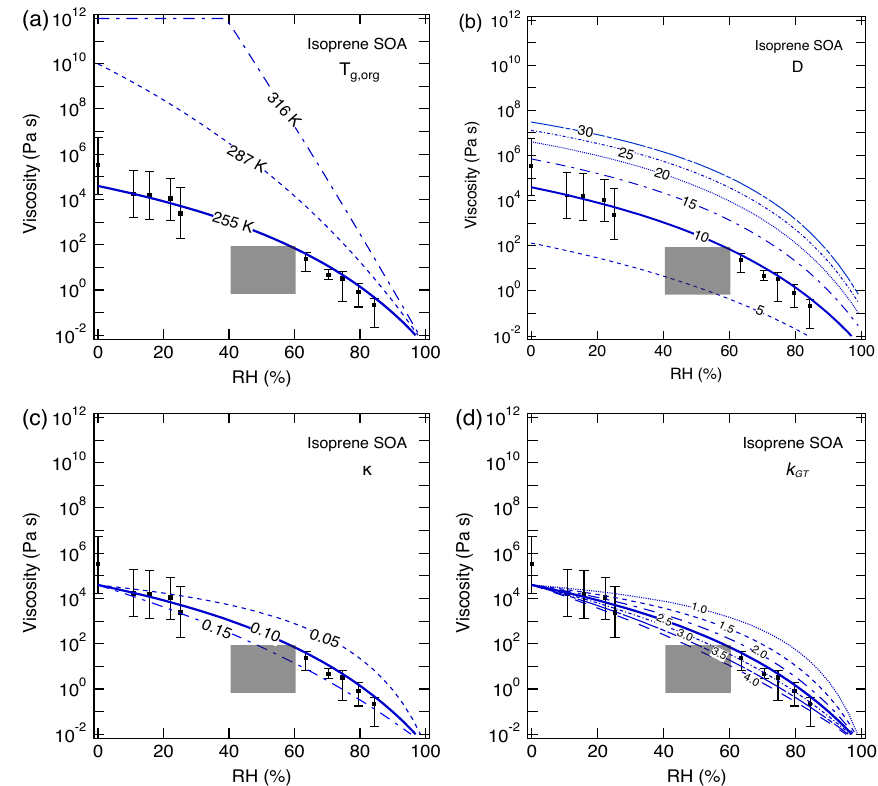
Figure 6. Sensitivity calculations for the viscosity of isoprene SOA at 295K as a function of RH by varying (a) the glass transition temper- ature of dry SOA ( T g , org ) , (b) fragility ( D) , (c) hygroscopicity ( κ) , and (d) the Gordon–Taylor constant ( k GT ) . Data points are measured viscosity by Song et al. (2015) and the gray box represents estimated viscosity based on the bounce measurements of Bateman et al. (2015).